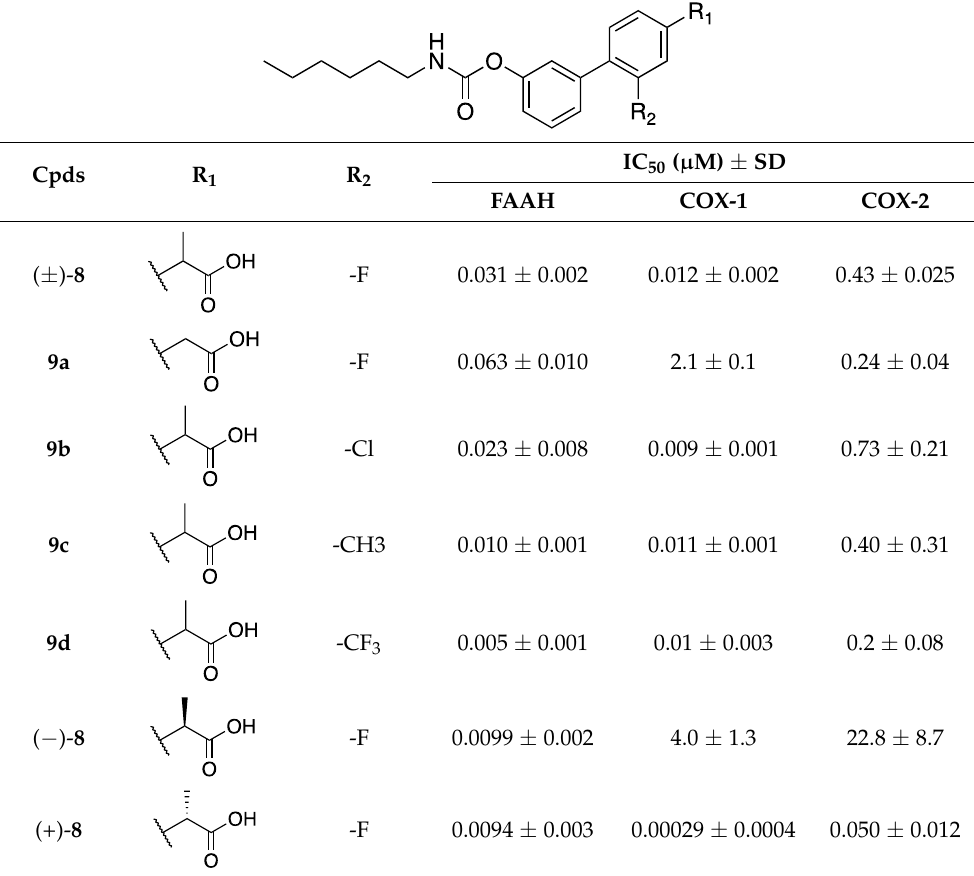
Table 5. FAAH, COX-1, and COX-2 activities of racemic compounds (±)- 8 , 9a – d , and single enantiomers compounds ( − )- 8 , and (+)- 8 .